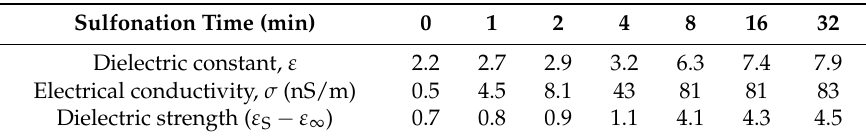
Figure 2. Effect of sulfonation reaction time on dielectric constant ( a ); electrical conductivity ( b ); dielectric loss factor values ( c ) of the PS particles. The dielectric constant experimental data is fitted by a combination of the Havriliak ‐ Negami function and the Jonscher power law model (for details see the Methods section). Table 1. List of particle dielectric constant ( ε ) and electrical conductivity ( σ ) values measured at a frequency of 100 Hz, and dielectric strength ( ε S − ε ∞ ) values estimated from fitting the dielectric constant experimental data with theoretical